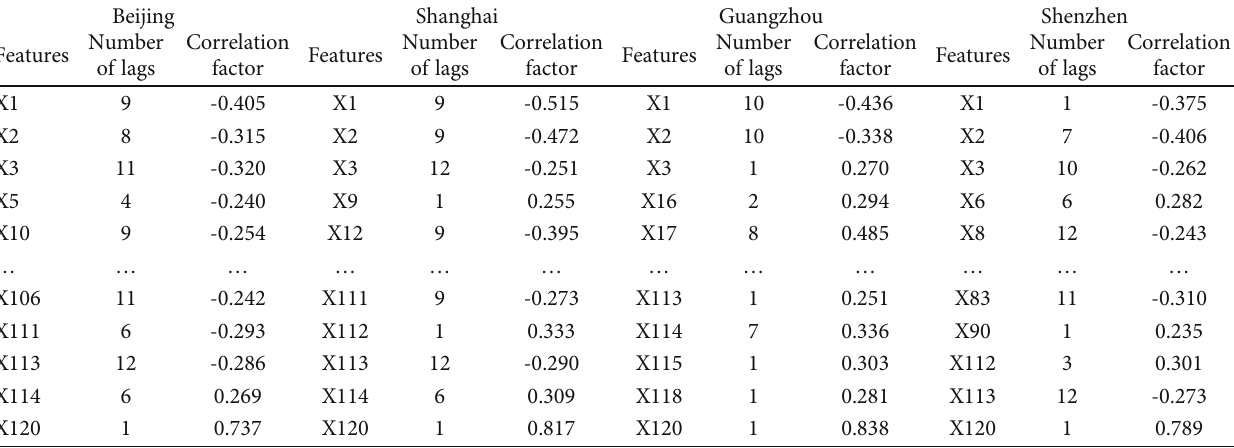
Table 2: Final forecast variables for the four